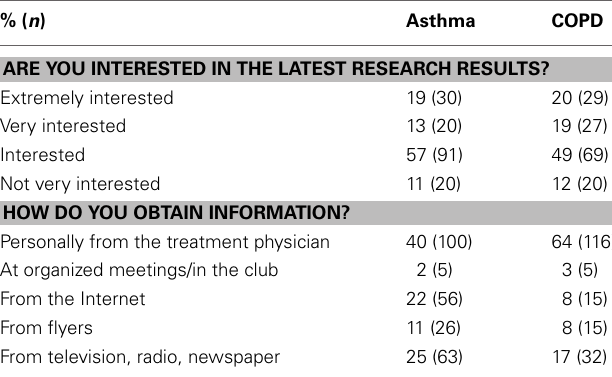
Table 3 | Information sources and commitment of patients.